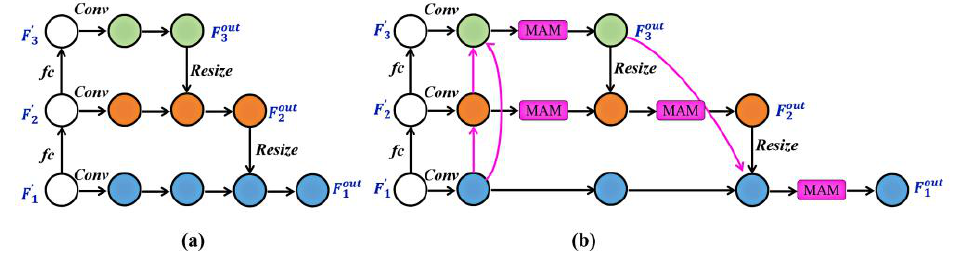
Figure 5. Comparison between ( a ) FPN and ( b ) the proposed BiPPAN decoder.